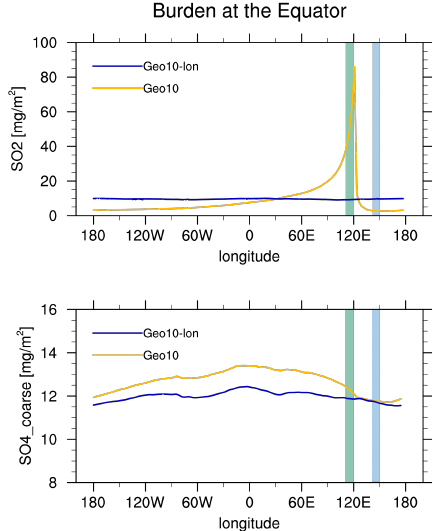
Figure 3. Burden of (top) SO 2 and (bottom) sulfate coarse-mode particles as calculated in the grid box along the Equator for two different simulations. Within the two marked areas concentrations are averaged for Fig. 4: downwind of the injection area at 110 to 120 ◦ E (green area, named AREA-115 later) and upwind to the in- jection area at 140 to 150 ◦ E (blue area, AREA-145). Meridionally both areas are one model grid box wide, from the Equator to 2.8 ◦